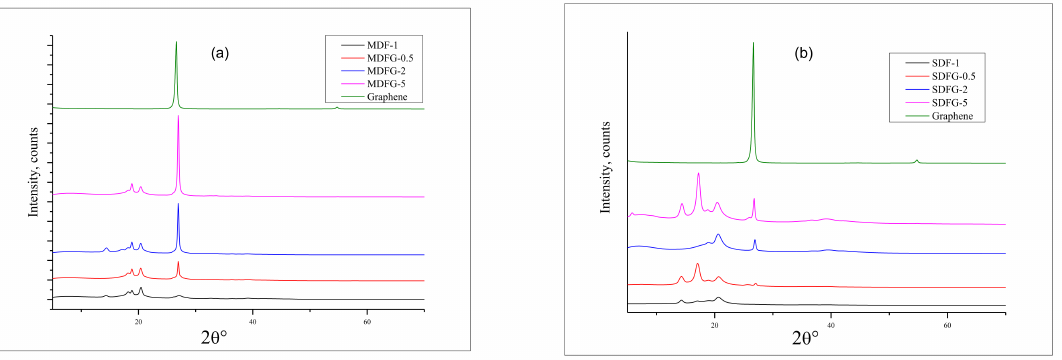
Figure 9. Overlay graphs of XRD of nanocomposites prepared by: ( a ) melt-mix method, and ( b ) the solution-cast